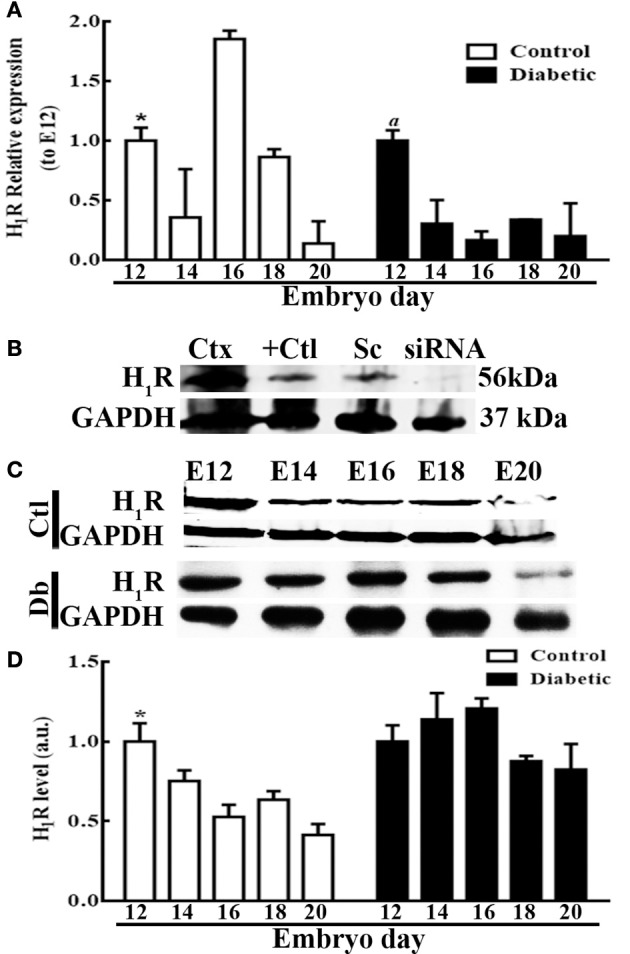
Temporal fetal H1R expression during corticogenesis in embryos from control and diabetic rats. (A) Graph of the temporal expression analysis of H1R in dorsal telencephalic (E12–E20) tissue from control (white bars) and diabetic groups (black bars). Data are the relative expression to E12 (S.E.M.) using the 2−ΔΔCT method from eight experiments per triplicate. One-way ANOVA was performed (Control, F(4, 31) = 8.6, P < 0.0001 and R2 = 0.5; Diabetic, F(4, 31) = 7.2, P = 0.0003 and R2 = 0.5), followed by Fisher's LDSs test, significant P-values in the control for *E12 vs. E14, E16, and E20 were: P = 0.03 (t = 2.2), P = 0.007 (t = 2.9), and P = 0.02 (t = 2.4) respectively, and DF = 31. And in the diabetic for aE12 vs. E14, E16, E18, and E20 were: P = 0.0004 (t = 3.9), P < 0.0001 (t = 4.7), P = 0.0007 (t = 3.8), and P = 0.0008 (t = 3.7) respectively, and DF = 31. (B) Western blot from three positive controls (Ctx = adult rat cerebral cortex, U373MG = glioblastoma cell line, and Sc = U373MG cells lipofected with scramble siRNAs) and one negative control (siRNA = U373MG cells lipofected with a pool of H1R-siRNA) for H1R (56 KDa) and GAPDH (37 KDa; internal control). (C) Representative temporal Western blots for H1R and GAPDH from control and diabetic samples. (D) Temporal densitometry analysis of H1R per group. The results are expressed as the mean (S.E.M.) of the normalized optical density for the control (white bars) and diabetic groups (black bars) expressed in arbitrary units (a.u.) from four independent experiments. One-way ANOVA was performed (Control, F(4, 15) = 8.2, P = 0.001, and R2 = 0.7; Diabetic, F(4, 15) = 2, P = 0.15, and R2 = 0.34), followed by Fisher's LDS test, significant P values in the control for *E12 vs. E14, E16, E18, and E20 were: P = 0.04 (t = 2.2), P = 0.0007 (t = 4.3), P = 0.005 (t = 3.3), and P < 0.0001 (t = 5.3) respectively, and DF = 15. E = embryonic day.